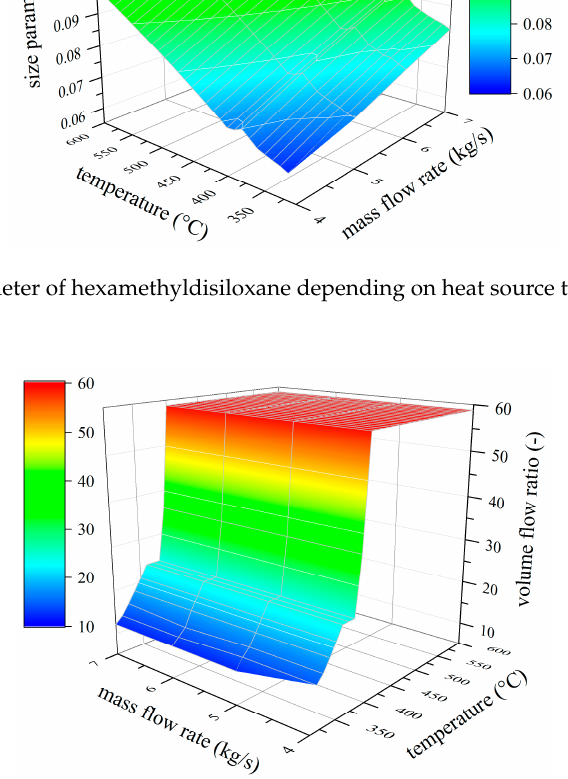
Figure 13. Volume flow ratio of hexamethyldisiloxane depending on heat source temperature and mass flow rate.